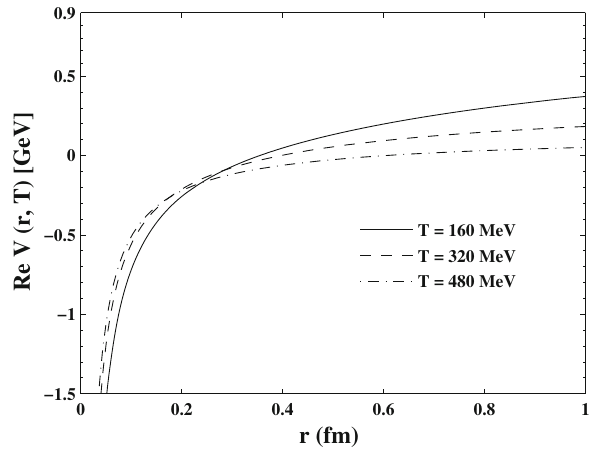
Fig. 1 Variationoftherealpartofpotentialwiththeseparationdistance r between the Q ¯ Q pair at three different values temperatures, i.e., T = 160 , 320 and 480 MeV